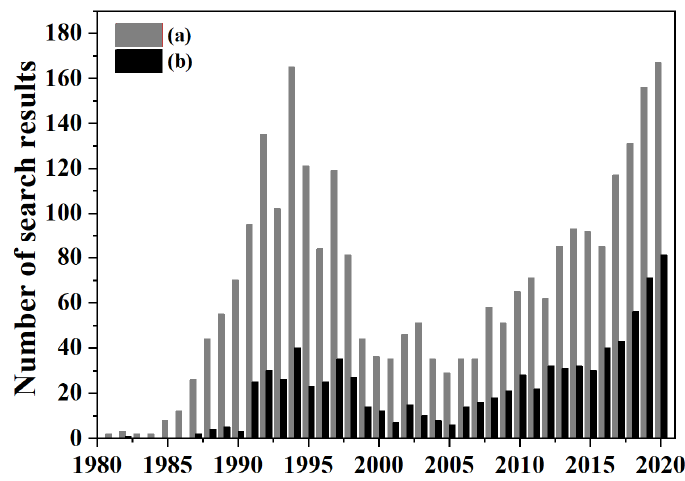
Figure 1. Chronological distributions of search results using the keyword sets (a): oxidative, methane and coupling; and (b): oxidative, methane, coupling and ethylene.